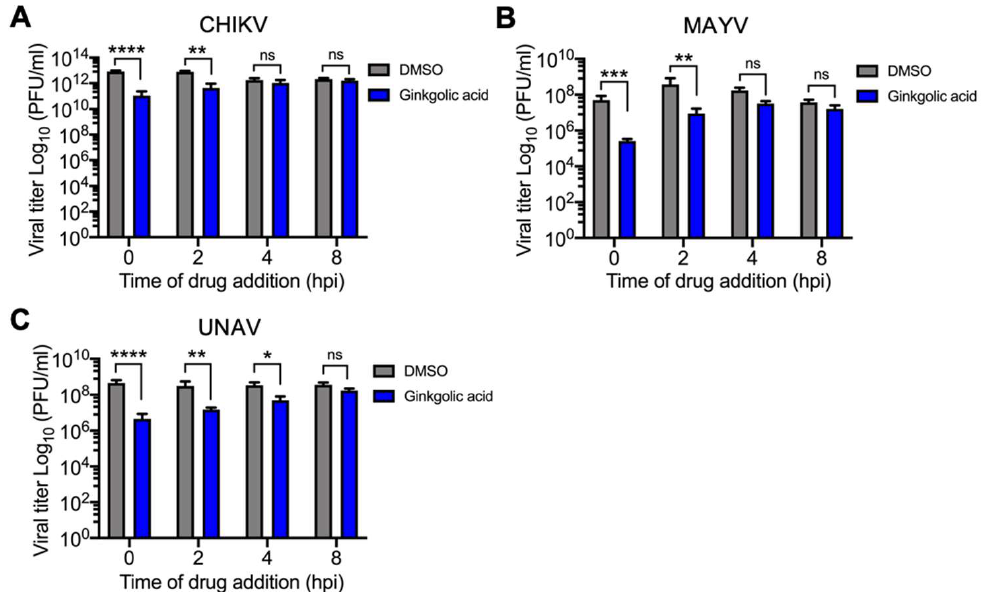
Figure 4. Ginkgolic acid prevents Alphavirus replication at an early stage of the viral cycle. Vero ( A ) or HeLa ( B , C ) cells were infected with CHIKV, MAYV, or UNAV and after 1 h of virus absorption, Ginkgolic acid or DMSO were applied to the cells at the indicated times. Then, the viral progeny production was measured in the cell supernatants after 24 h of incubation with the Ginkgolic acid or DMSO as previously indicated. The viral titers were expressed as plaque-forming units per milliliter (PFU/mL). Data were analyzed with the Two-way ANOVA test. Statistically significant differences are shown: *p < 0.05; **p < 0.01; ***p < 0.001; ****p < 0.0001; ns: non-significant.